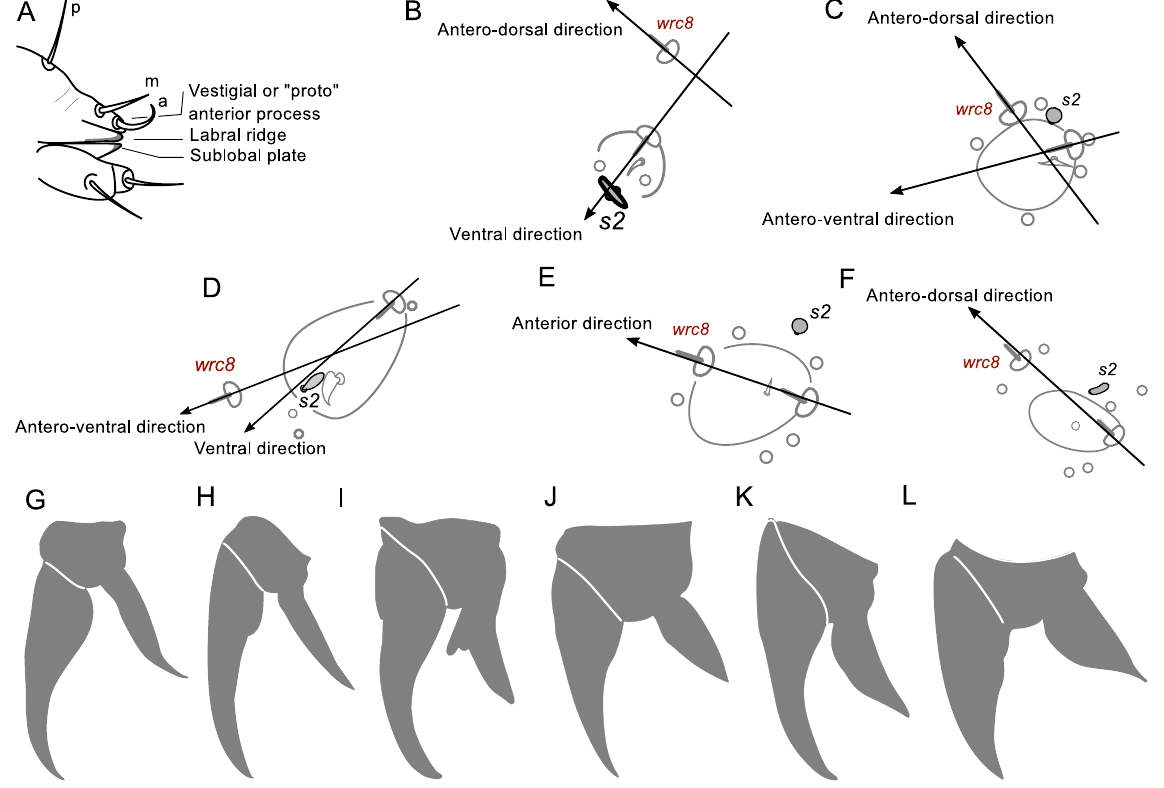
Fig. 9. A . Schematic interpretation of the labrum of Spinaethorax adamantis sp. nov. B–F . Chaetotaxic organization of sf6 . B . Neelus murinus . C . Megalothorax minimus . D . Spinaethorax adamantis sp. nov. E . Megalothorax granulosus. F . Acanthoneelidus pratensis . G–L . Outline of claw III,